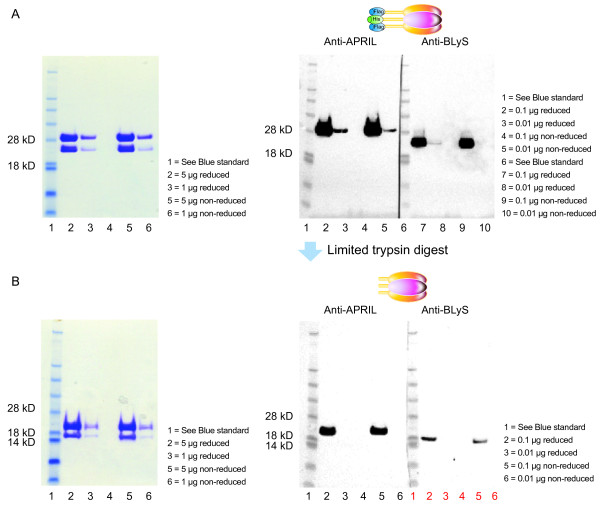
Sodium dodecylsulfate polyacrylamide gel electrophoresis and Western blot analysis of (a) BLyS/APRIL heterotrimer and (b) trypsinized (nonzippered) heterotrimer. APRIL, a proliferation-inducing ligand; BLyS, B-lymphocyte stimulator.